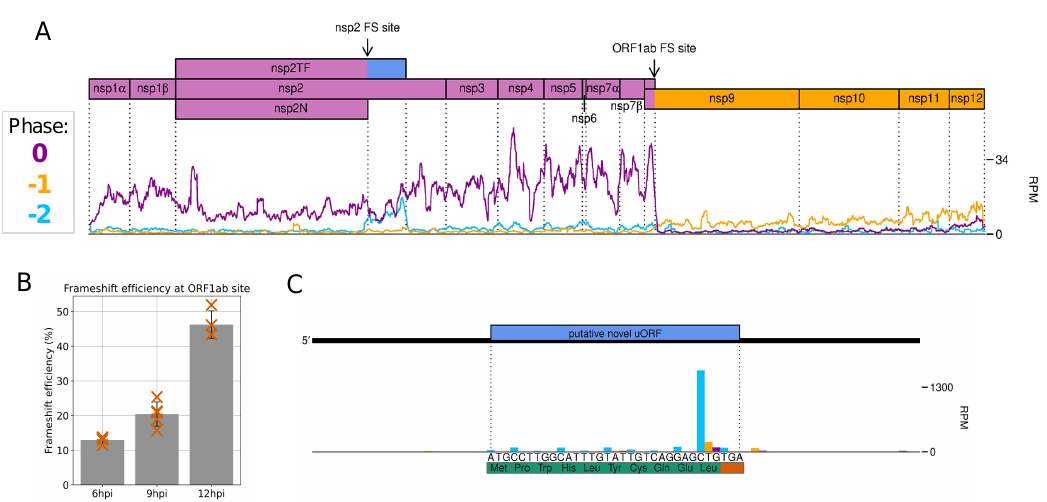
Figure 2. Ribosome profiling of PRRSV-2, displaying reads mapped to the polyprotein region of the genome. ( A ) Read density at each position, after application of a 27-codon sliding window running mean, coloured according to phase (codon position to which the 5 (cid:48) end of a read maps). An increase in the proportion of reads in the − 2 phase (blue) is visible in the transframe region directly following the nsp2 frameshift site. The dominant phase returns to 0 (purple) after the stop codon in the − 2 frame causes termination of frameshifted ribosomes. After the ORF1ab frameshift site, the ribosome density decreases, as ribosomes which do not frameshift encounter a stop codon, and ribosomes which undergo − 1 PRF continue translation in the − 1 frame, resulting in reads predominantly in the − 1 phase (yellow). ( B ) Frameshift efficiency at the ORF1ab site increases as infection progresses. ( C ) A small but highly expressed upstream ORF (uORF) in the 5 (cid:48) UTR of the PRRSV genome. The prominent peak corresponding to terminating ribosomes is characteristic of samples harvested without drug